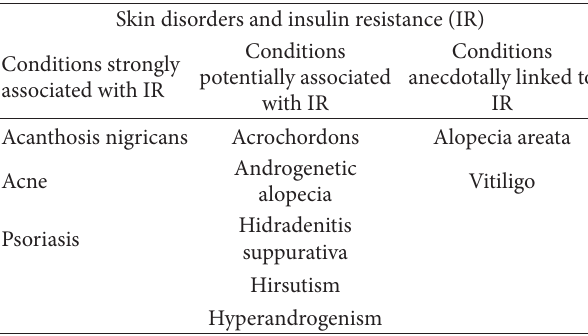
Table 1: Skin diseases associated with insulin resistance. Skin disorders and insulin resistance (IR)